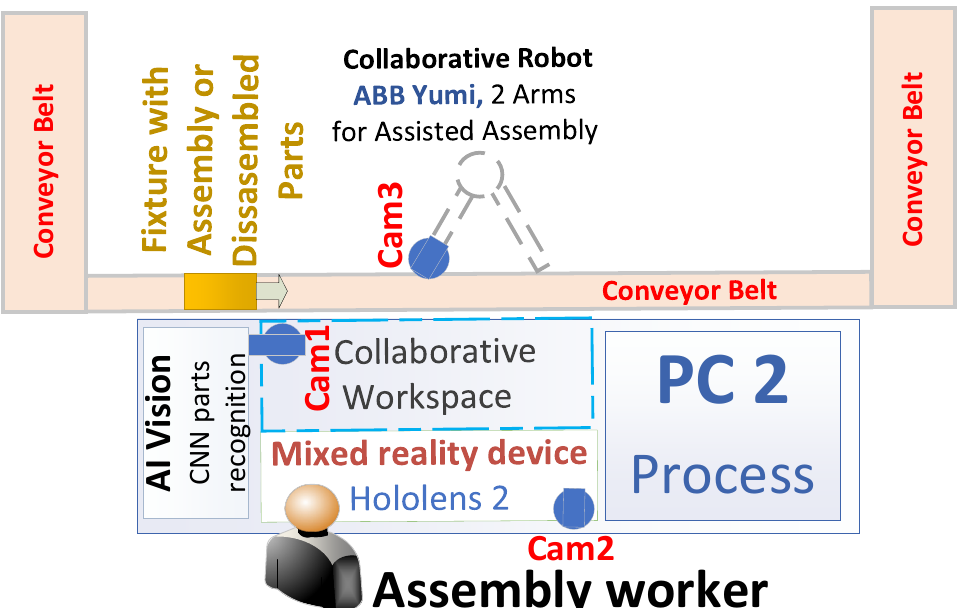
Figure 2. A scheme of the experimental assisted assembly work cell with CNN processing unit, mixed reality device and collaborative robot.